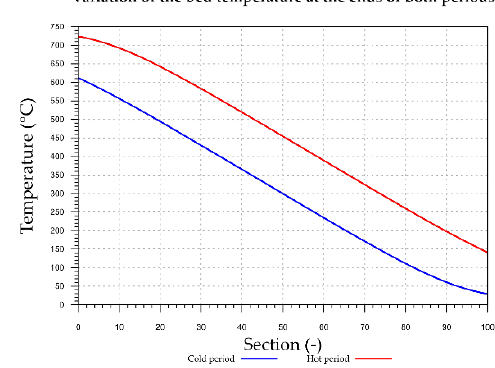
Figure 8. Dependences of temperatures on the location.